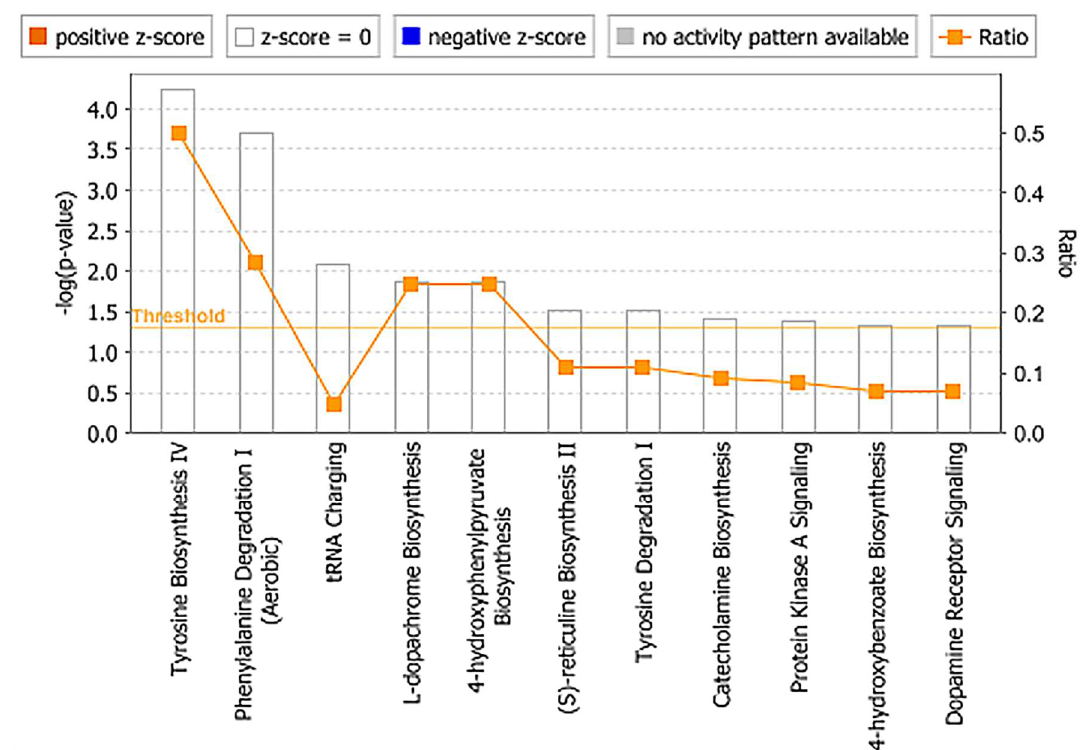
Figure 9. Ingenuity functional pathway analysis shows changes in tyrosine biosynthesis and phenylalanine degradation pathways after po administration of BIO 300 in NHPs.